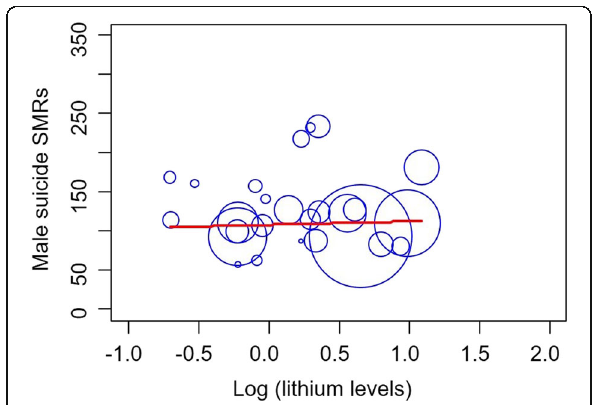
Fig. 1 Lithium levels in drinking water and male suicide SMRs. The lithium levels are log-transformed, and the size of the dot represents population size. Male suicide SMRs were not associated with lithium levels ( β = 0.061, p =